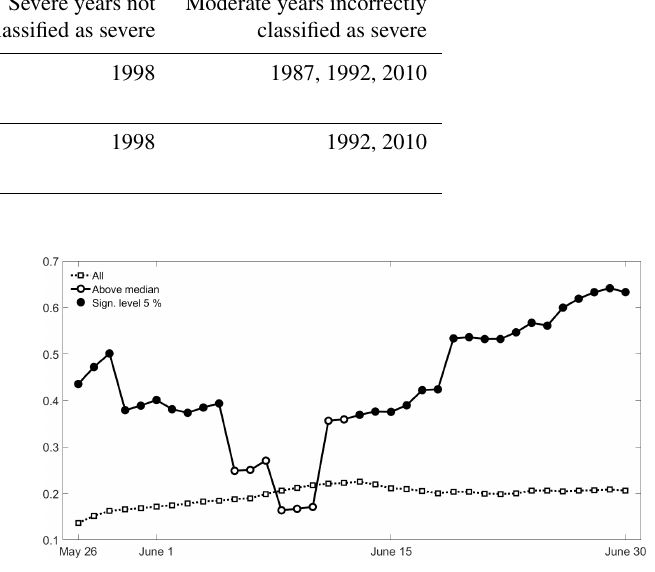
Figure 8. Temporal evolution of the correlation between ψ (d) and χ from 26 May to 30 June for all years (dotted curve) and restrict- ing to years ψ (d) larger than the respective median (solid curve). Black circles in the solid curve identify values of correlation that are significant at the 5%